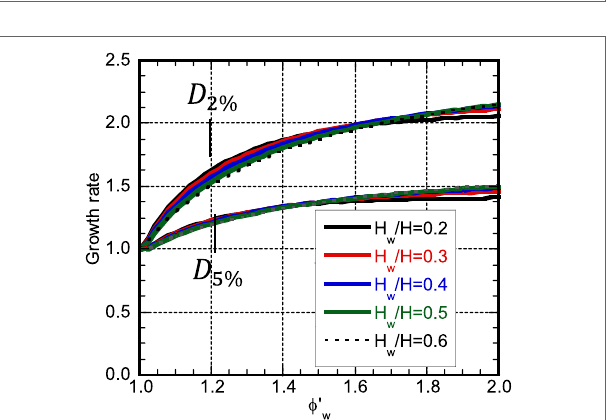
FIGURE 9 | Comparison of approximation with time-history response analysis: (A) 1 u ′ max and (B) 2 u ′ max .